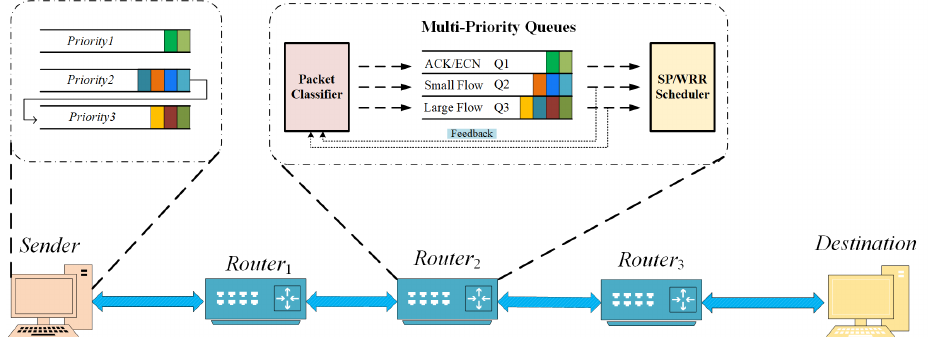
Figure 1. The overall design framework of HDCQ